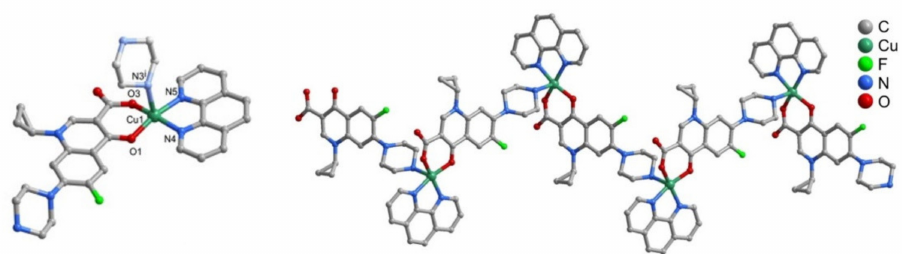
Figure 3. Representation of ( left ) the cationic complex [Cu(cpx)(phen)] + and of ( right ) the coordi- nation chain of [Cu(cpx)(phen)] + , formed in the crystal structure of Cucpxphen. Reprinted